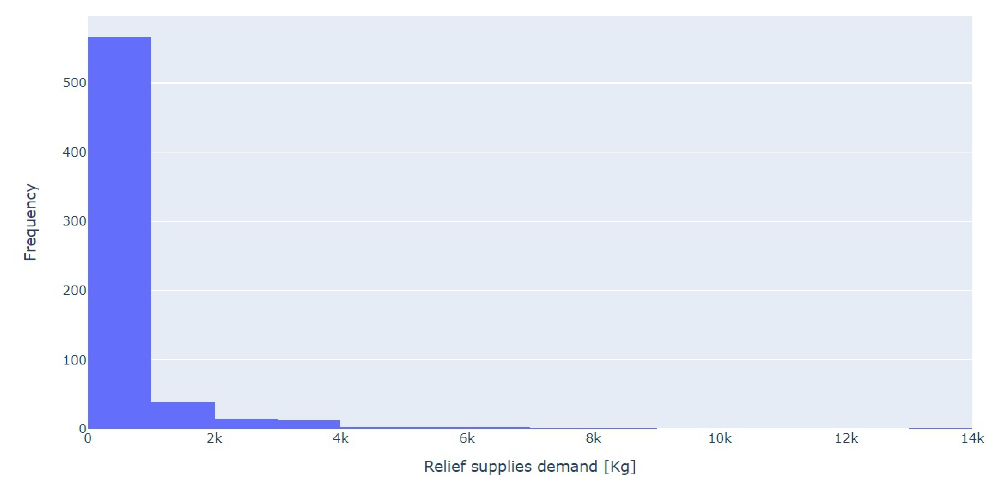
Figure 2. Histogram of the average demand for relief